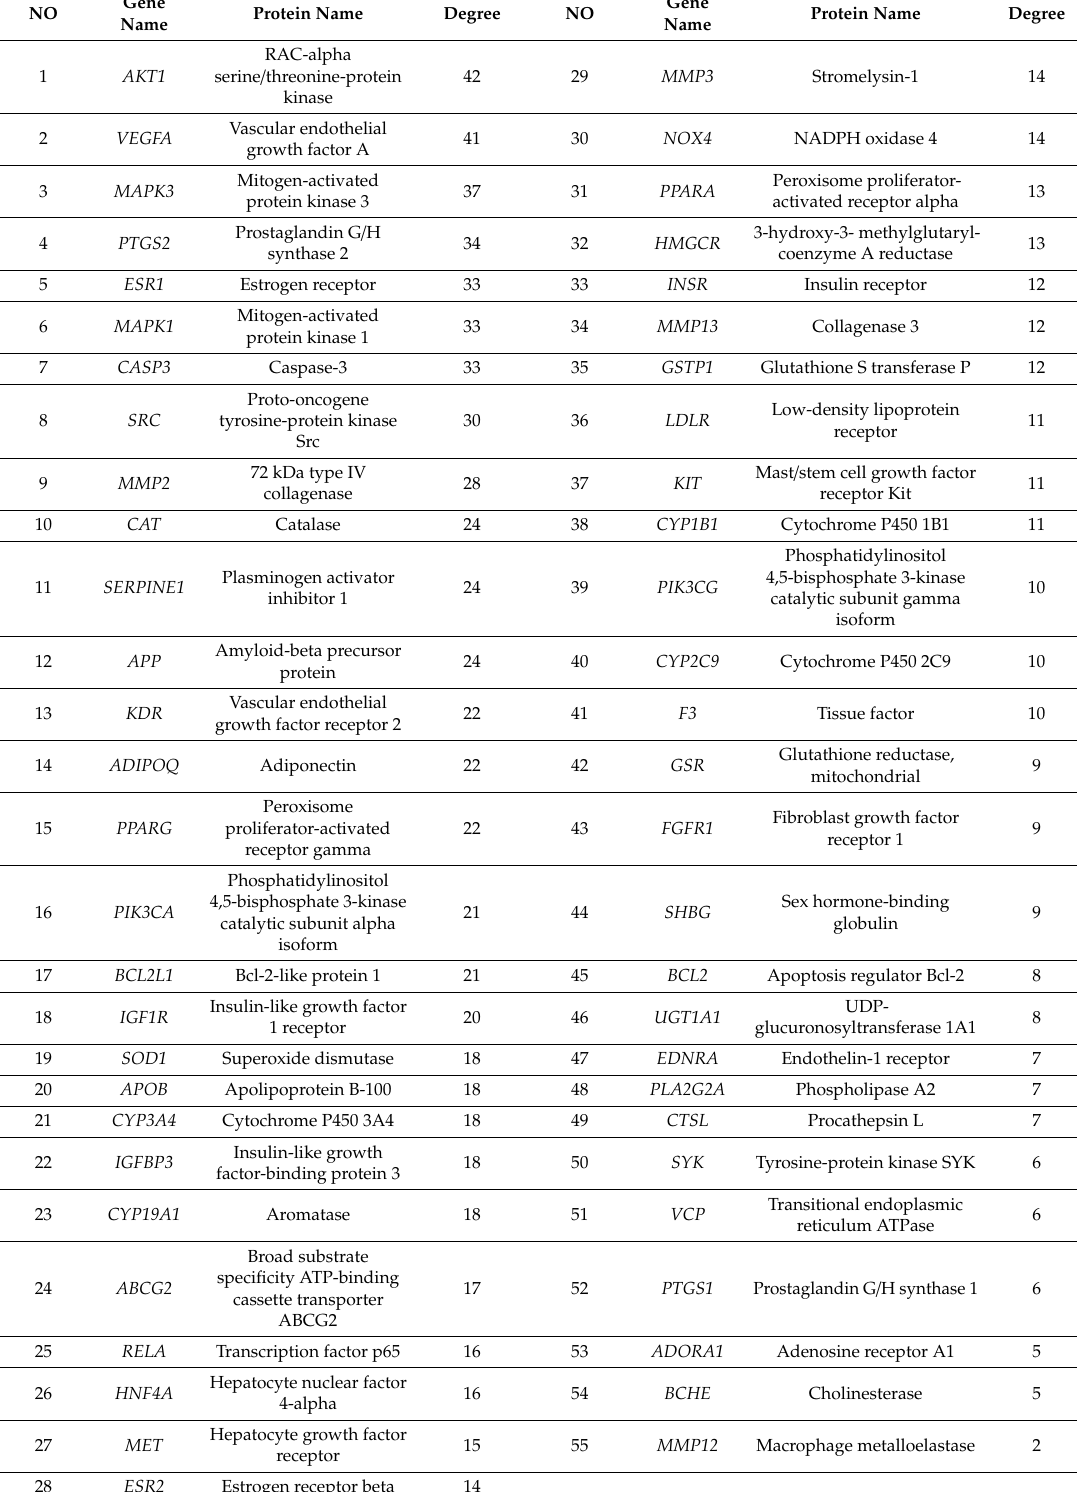
Table 7. The list of 55 core targets ranked by degree value.